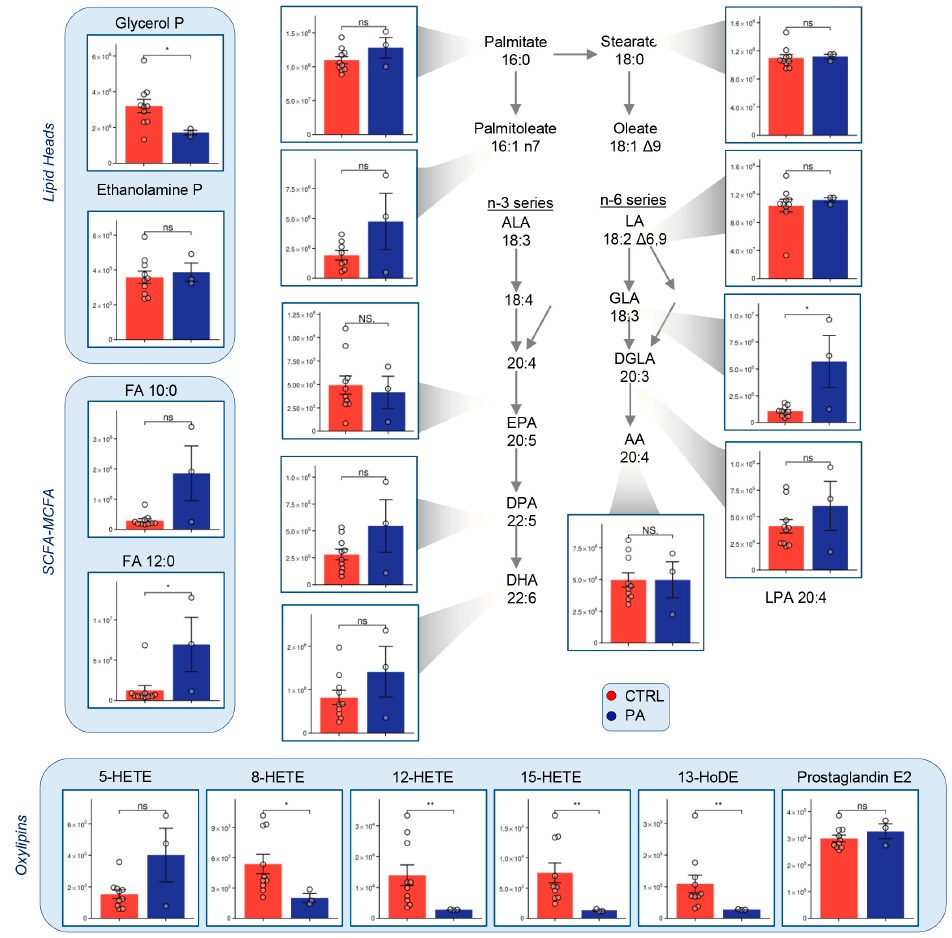
5 Figure 5. PA remodels fatty acid metabolism in RBC. Y-axes represent peak area (arbitrary units). Asterisks indicate significant results, error bars represent ± standard error of the mean (unpaired t -test, 2-tailed distribution, * p < 0.05, ** p <